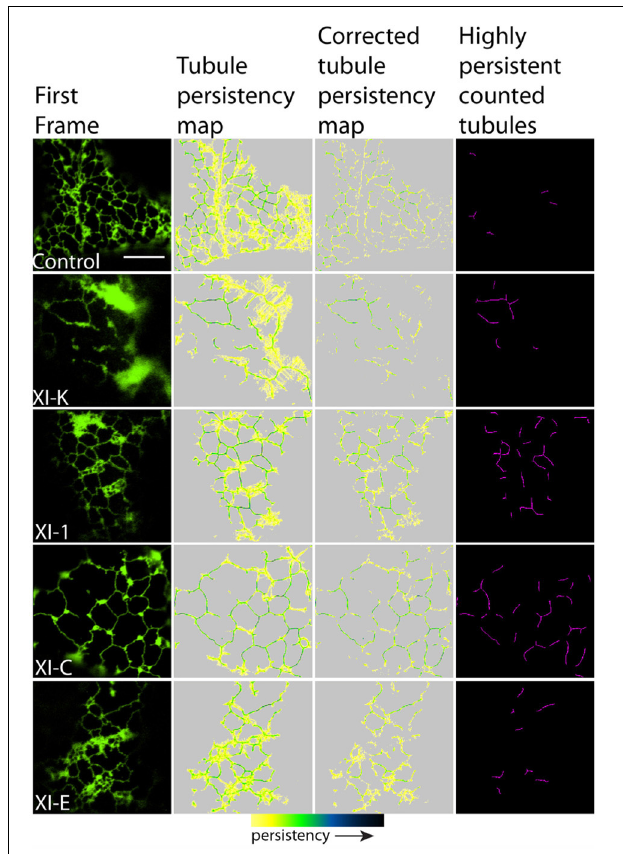
FIGURE 2 | Effects of XI-K, XI-C, XI-E, and XI-1 myosin tail domains on persistent ER tubules identified with co-expressed GFP-HDEL. Left-hand panel is the first frame of a 50 frame movie. Middle two panels are tubule persistency expressed as the sum of skeletonized tubules that persist for five frames (7.9s).The corrected tubule persistency subtracts out contributing skeletons from cisternal regions. The yellow-green-blue-black persistency scale represents persistency from 7.9 to 80s. Highly persistent tubules are those that are counted for Figure 4 , being both greater than 0.2 µ m 2 and persisting for at least a third of total movie time (black to green on the persistency scale with black representing persistency through the whole 80s and green representing persistency for approximately 23s). Note, control refers to cells only expressing the ER marker GFPHDEL (green, left hand panel).